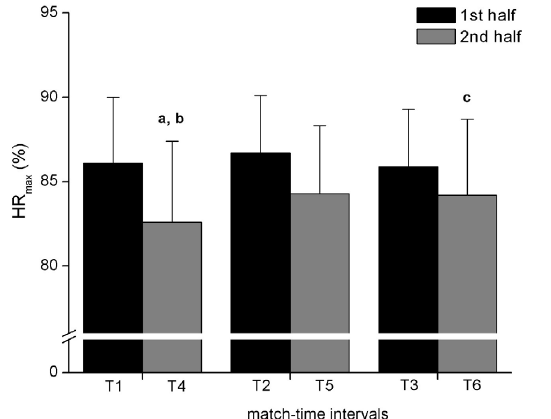
Figure 2. Player internal load expressed as percentage of individual maximal heart rate in different match-time intervals during official games in youth soccer players (n=21). Data are expressed as mean ± SD. a, denotes significant difference vs. all fist half time match intervals ( p <.001); b, denotes significant difference vs. T5 and T6 ( p <.01); c , denotes significant difference vs. T1 and T2 ( p